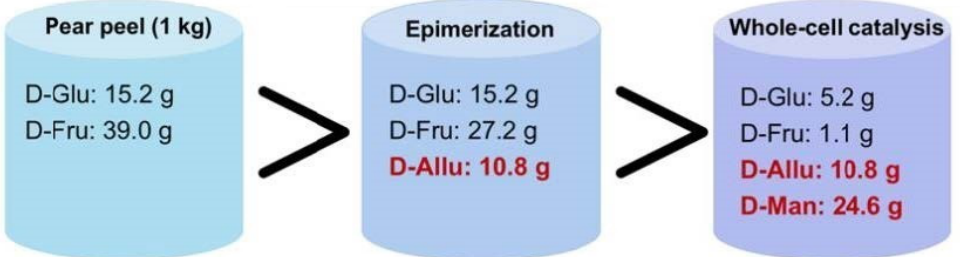
Figure 6. Overall mass balance for epimerization; whole-cell catalysis.